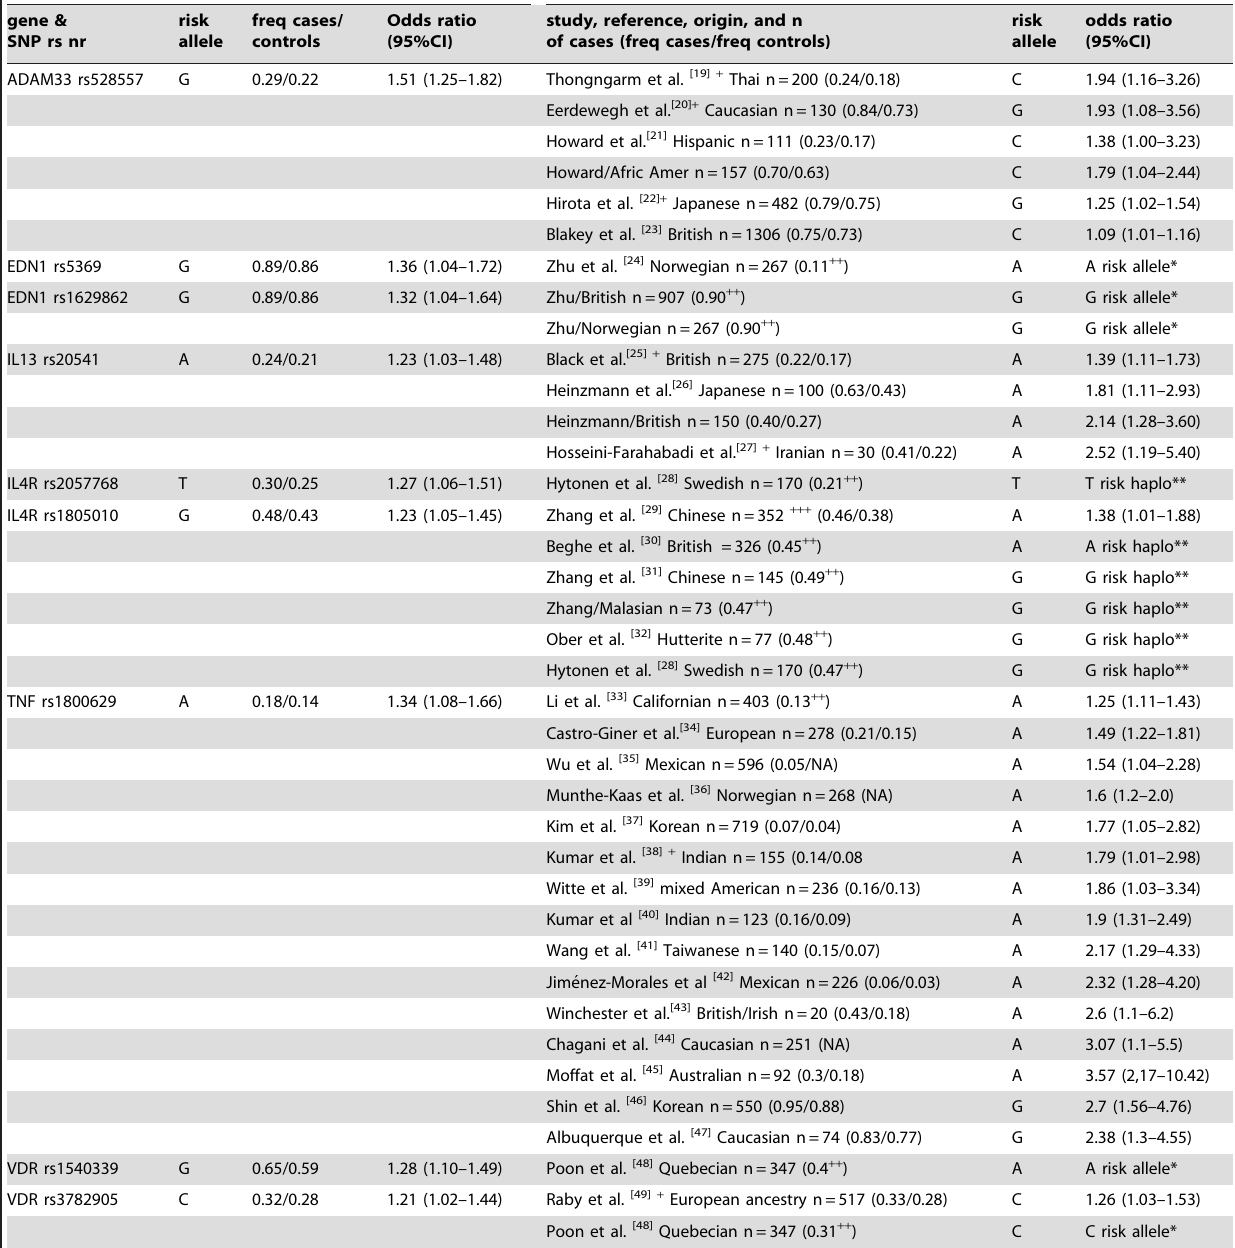
Table 1. Comparison of risk allele, frequency of risk allele in cases and controls and effect size in our study population and previously published studies for candidate gene polymorphisms with a p- value of , 0.05 in our population (for complete results on all tested SNPSs see table